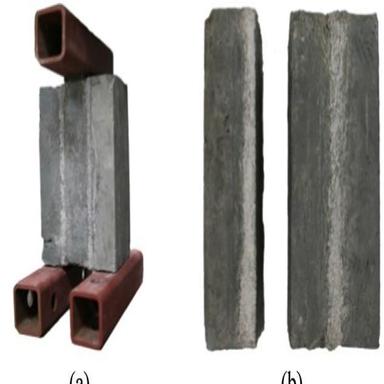
Characterization of shear bond strength: (a) triple-brick sample, (b) cohesive failure (slipping).